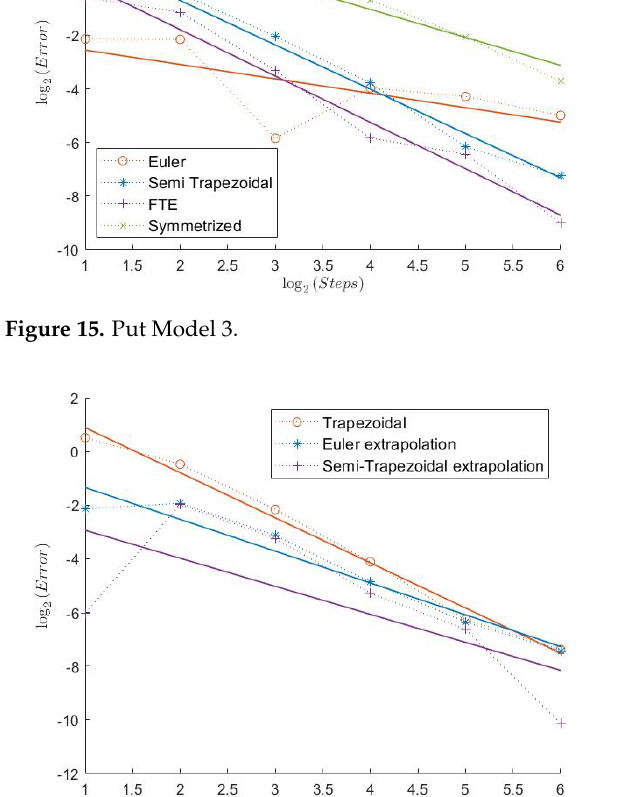
Figure 14. Call Model 3.